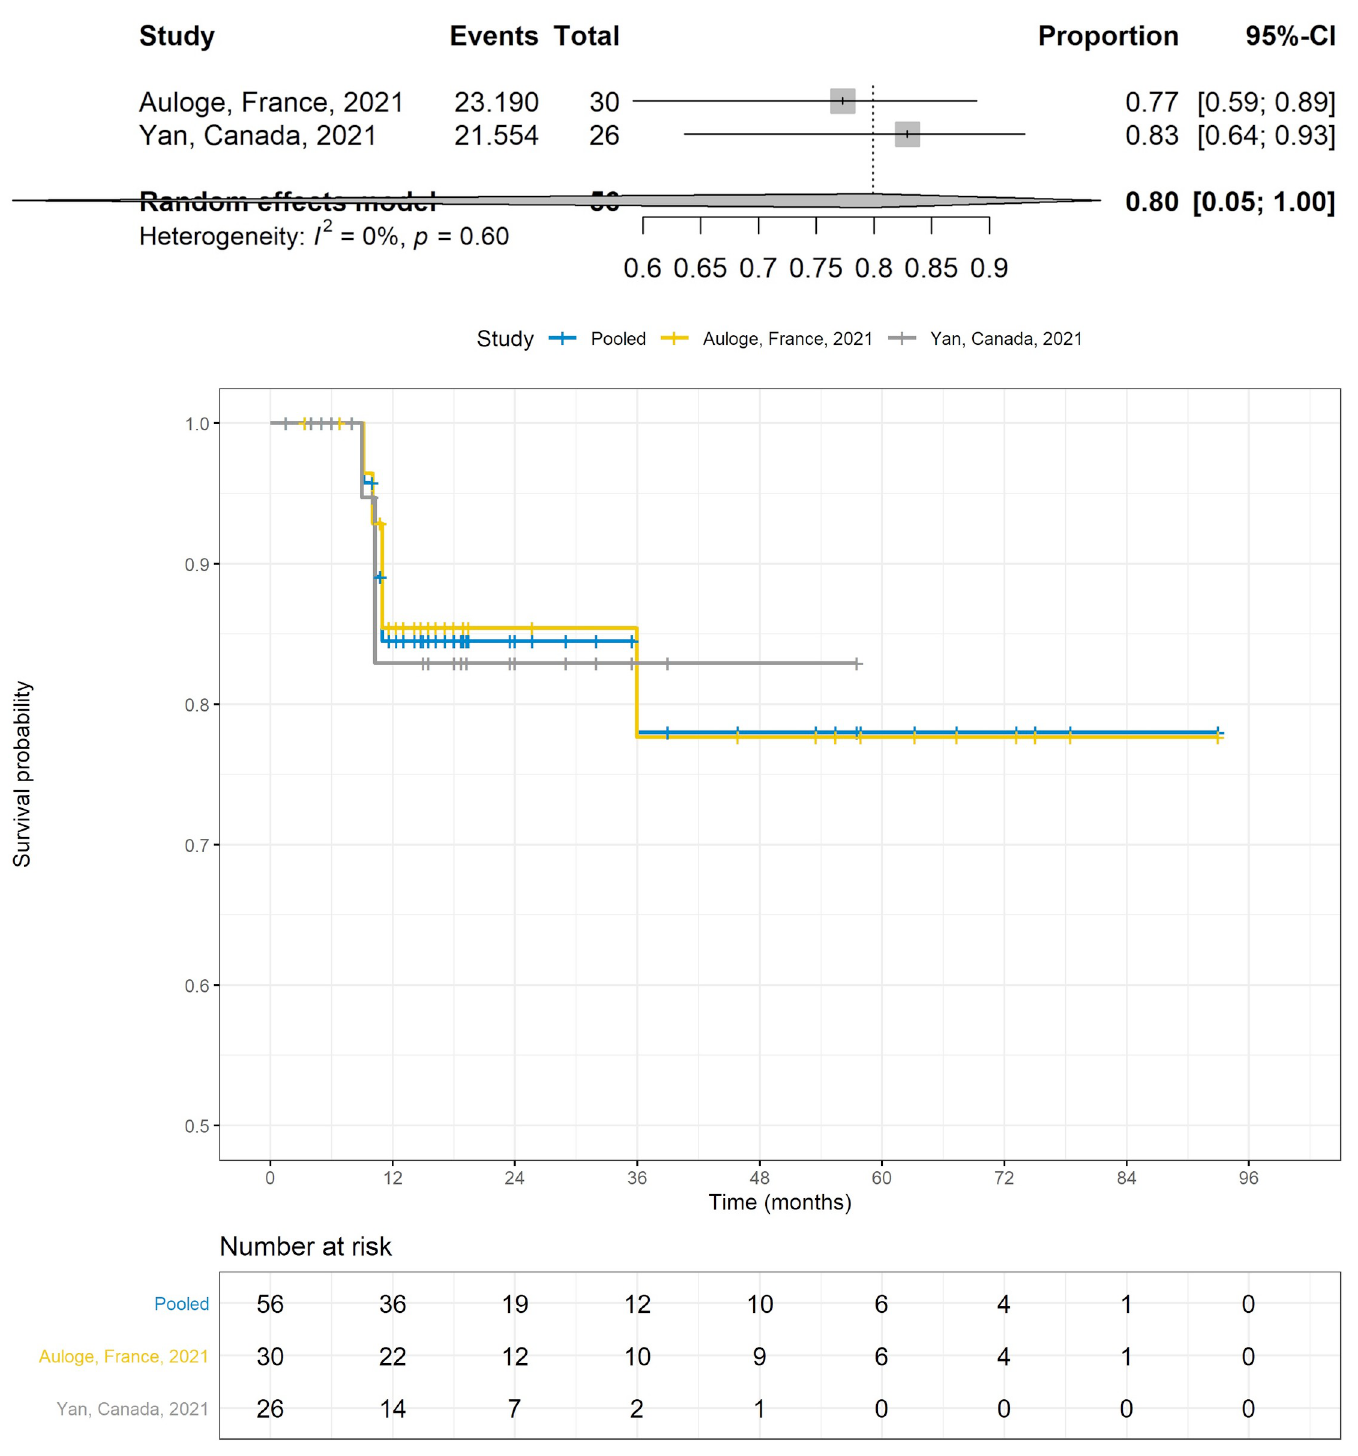
Fig 5. Pooled (Fig 5A) and individual survival curves (Fig 5B) using mRECIST for tumor response.